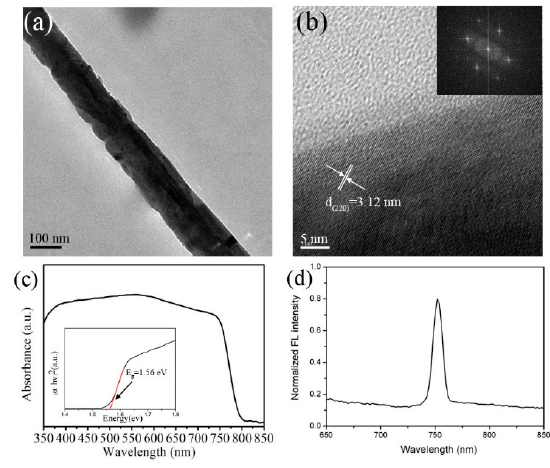
Figure 4. The morphology and optical properties characterization of the synthesized perovskite MAPbI 3 nanowires. ( a ) TEM image; ( b ) HRTEM image; ( c ) UV-vis absorbance spectra and ( d ) fluorescence spectra.